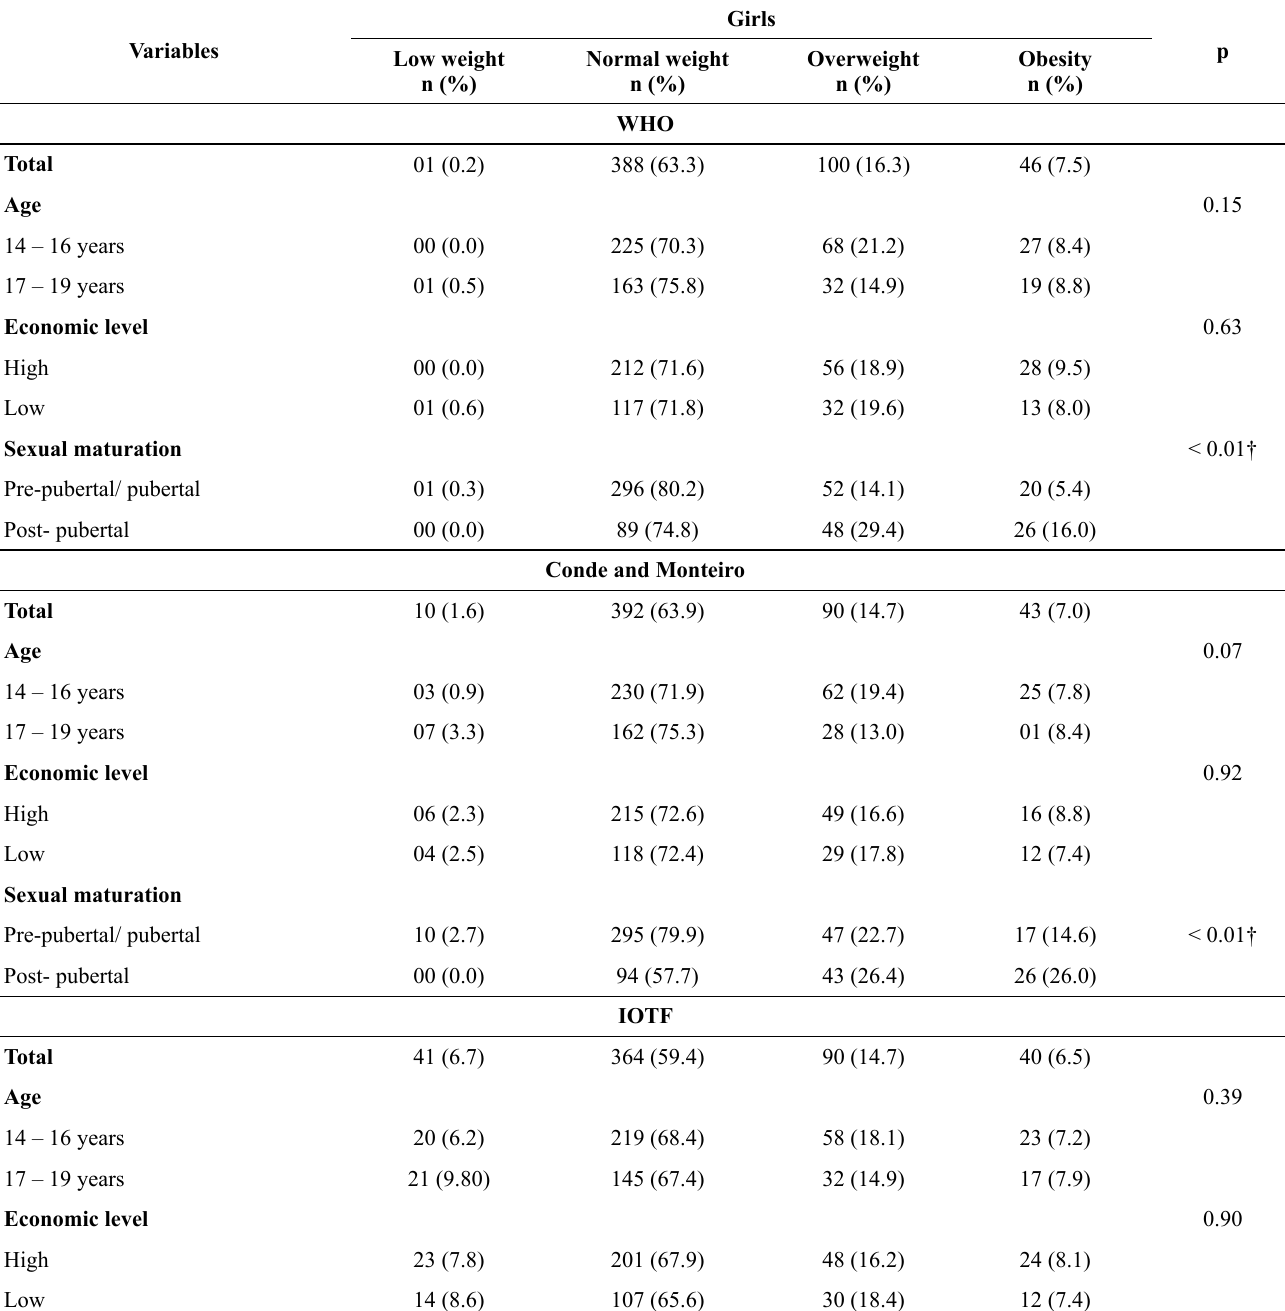
Table 2. Sample distribution in relation to sociodemographic factors associated with nutritional status classification according to three different criteria for girls (n =613, São José, Santa Catarina,